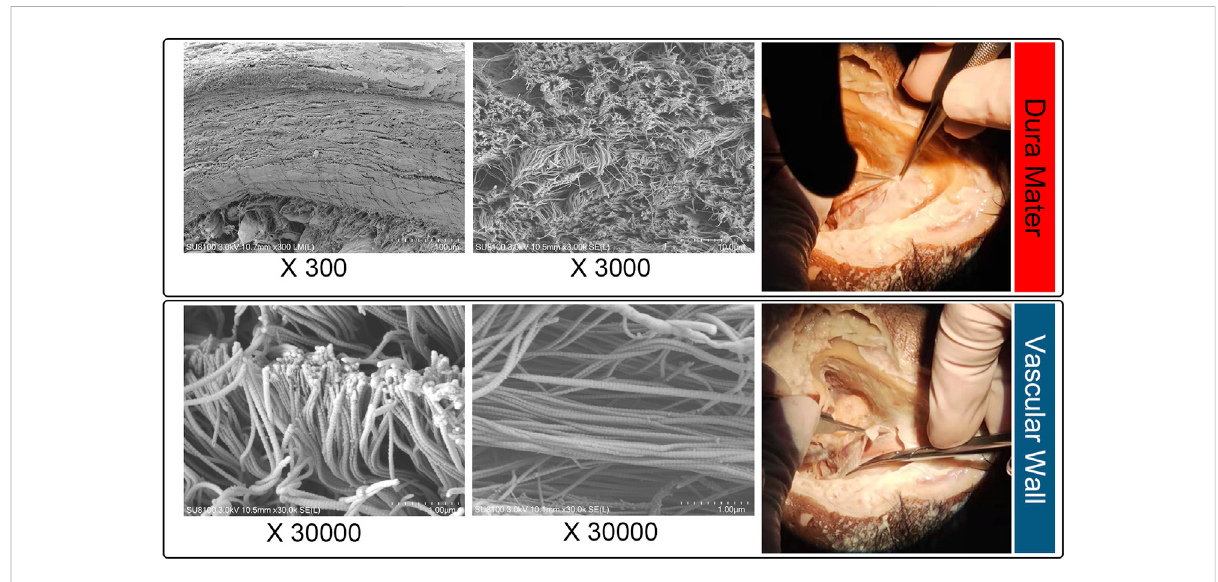
FIGURE 3 Microstructural examination of cadaveric specimens: dura mater (upper panel) and sigmoid sinus vascular wall (lower